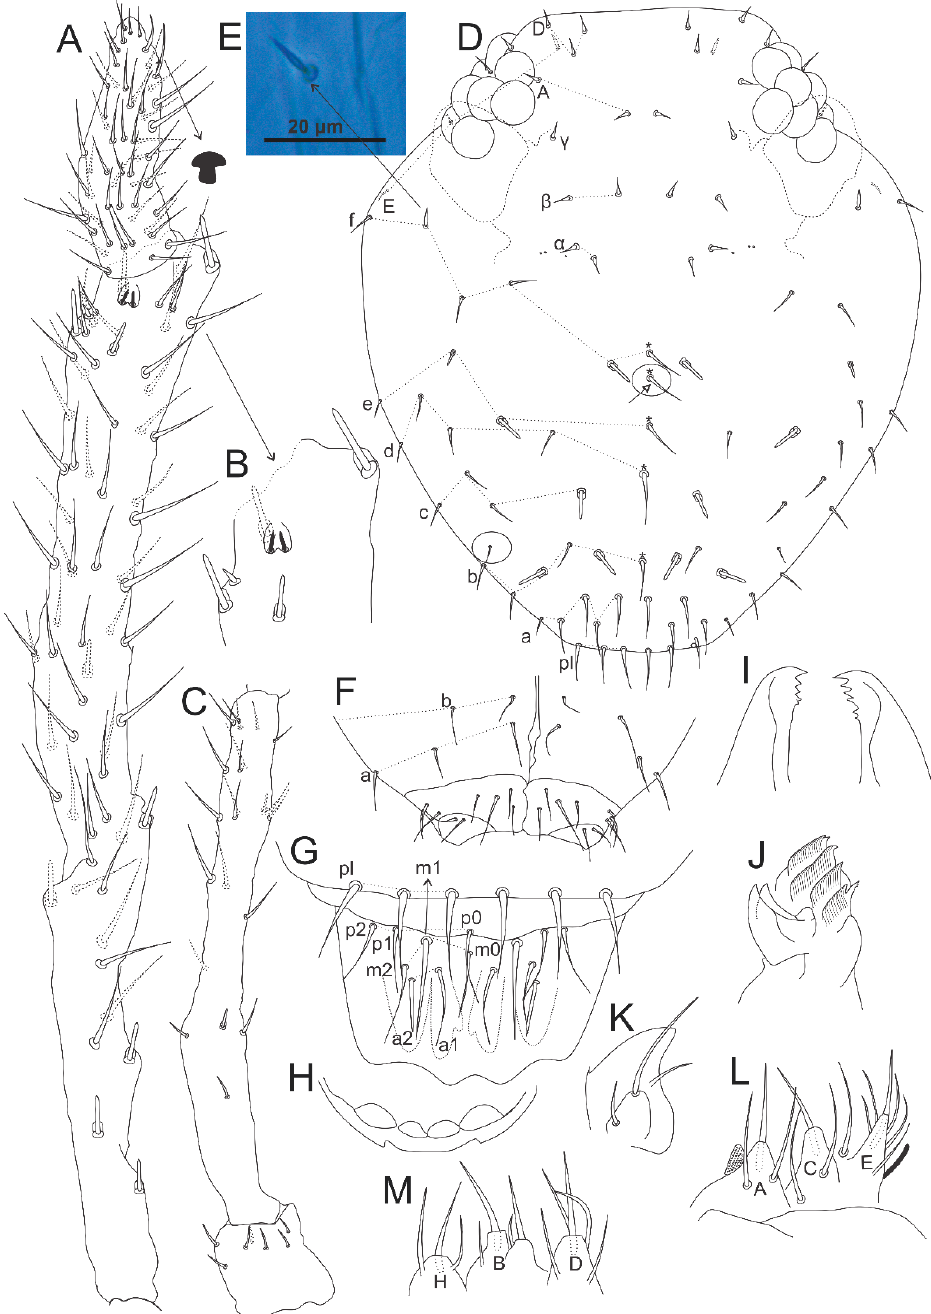
Figure 20. Calvatomina gladiata sp. nov. head: ( A ) Ant IV and Ant III ventral view (left side), arrow points to the subapical organ of Ant IV “mushroom ‐ like”; ( B ) Ant III apex, with the apical organ, surrounding cup sensilla and microsensillum; ( C ) Ant II and I dorsal view (left side); ( D ) dorsal head chaetotaxy, antennal bases marked with dotted lines, circles indicate chaetae without clear homologies, asterisk indicate unpaired chaetae, white arrow indicates a chaeta present or absent; ( E ) acanthoid chaeta of f line; ( F ) ventral head chaetotaxy including basal labium (basomedian and basolateral fields); ( G ) prelabral and labral chaetotaxy; ( H ) labral papillae region; ( I ) mandibles apex (ventral view); ( J ) left maxilla capitulum (ventral view); ( K ) left maxillary outer lobe and sublobal plate; ( L ) labial palp papillae A, C and E and proximal chaetae (right side); ( M ) labial palp papillae H, B and D (right side).